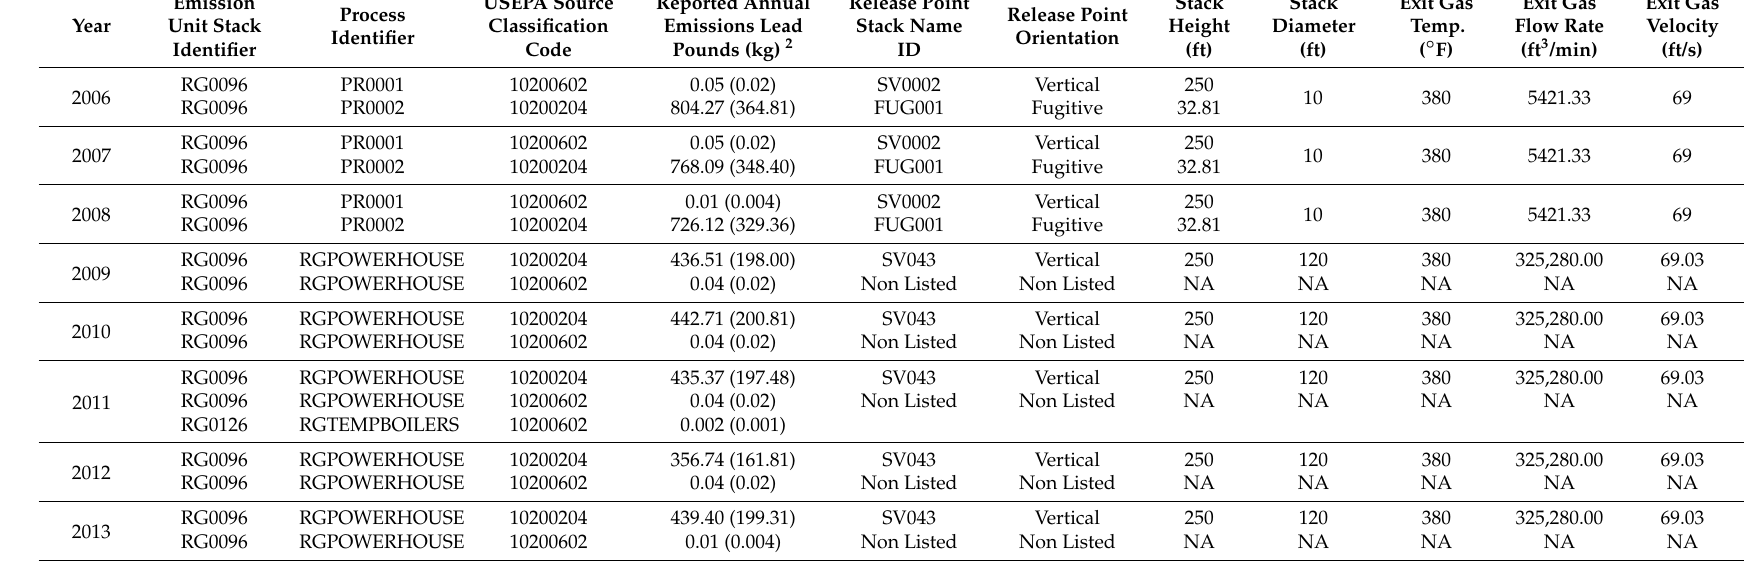
Table 1. AERMOD facility identifying information for the largest emitter of lead 1 over the study period in the Detroit Metropolitan Area,